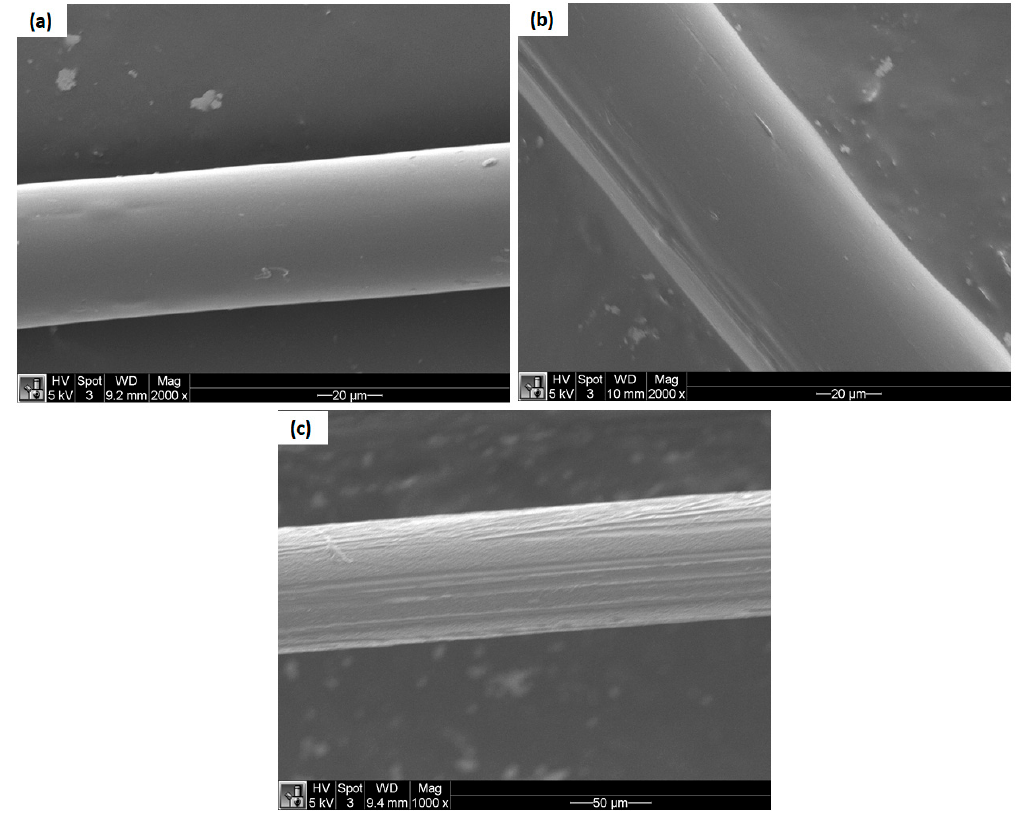
Figure 6. Surface SEM images of PLA/APP5/PES10/KL1 ( a ), PLA/APP5/PES10/KL3 ( b ), PLA/APP5/PES10/KL5 ( c ), bicomponent composite fibers [1000 × and 20 µm].